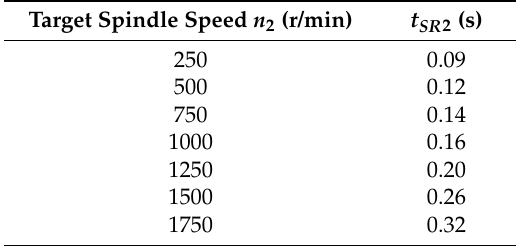
Table 2. Duration from peak power to stable power ( t SR 2 ) under different target spindle speeds.